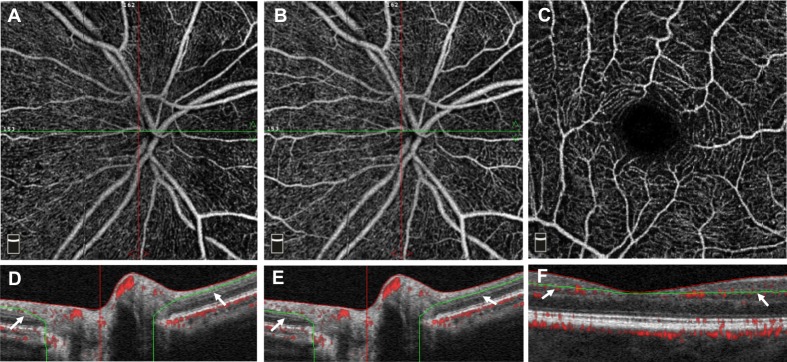
Optical coherence tomography angiography (OCTA) segmentation of the disc and macula.(A) shows a 4.5 x 4.5mm2
en face OCTA image of the radial peripapillary capillary (RPC) centered on the optic disc of a healthy control, and (D) shows the cross-section segmentation of the RPC. (B) shows the en face image of the superficial vascular complex (SVC) segmentation obtained from the same individual with (E) showing the cross-section of SVC. (C) shows 3.0 x 3.0mm2
en face scan of the superficial capillary plexus (SCP) centered on the of the fovea of the same individual with (F) showing the cross-section segmentation of the SCP.